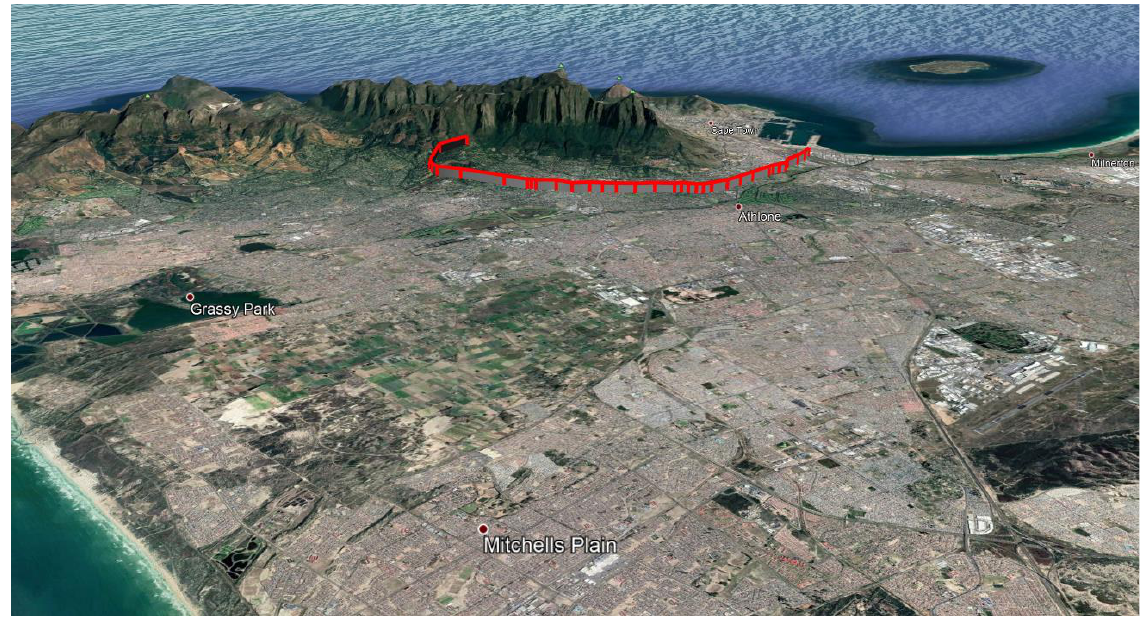
Figure 3 View of Cape Town with boundary